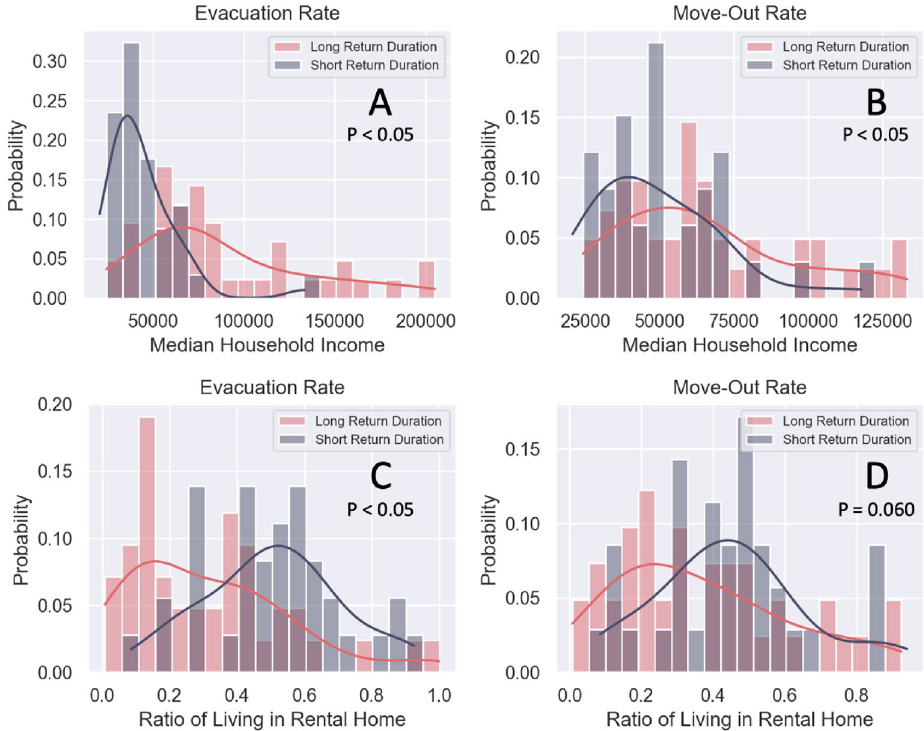
Figure 6. Comparison between long and short return durations with respect to the median household income ( A , B ) and the ratio of the population living in rental homes ( C , D ) of the evacuation ( A , C ) and move-out rates ( B , D ). The statistical test results indicate that the differences between long and short return durations are significant except for the difference in the move-out rate in terms of the ratio of living in renting